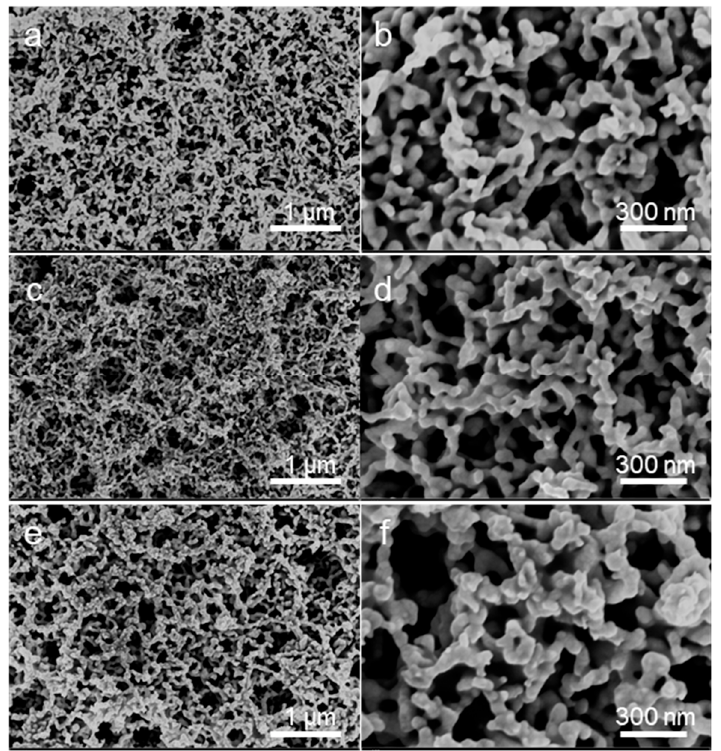
Figure 4. SEM images of the NPG electrode treated with plasma with different powers: ( a , b ) 60 W, ( c , d ) 70 W, ( e , f ) 80 W. Dry air was supplied during the plasma treatment.